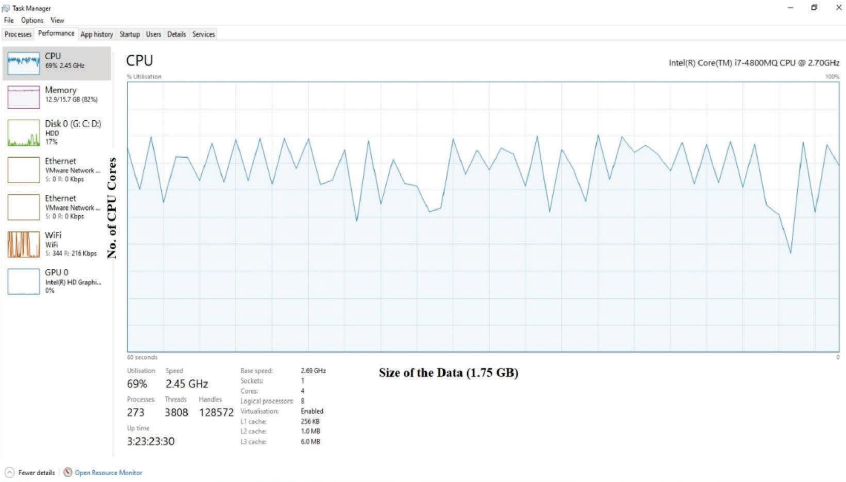
Figure 4: Te CPU utilization of Omicron CT-scan image data from the Google database, UCI, and Kaggle dataset.